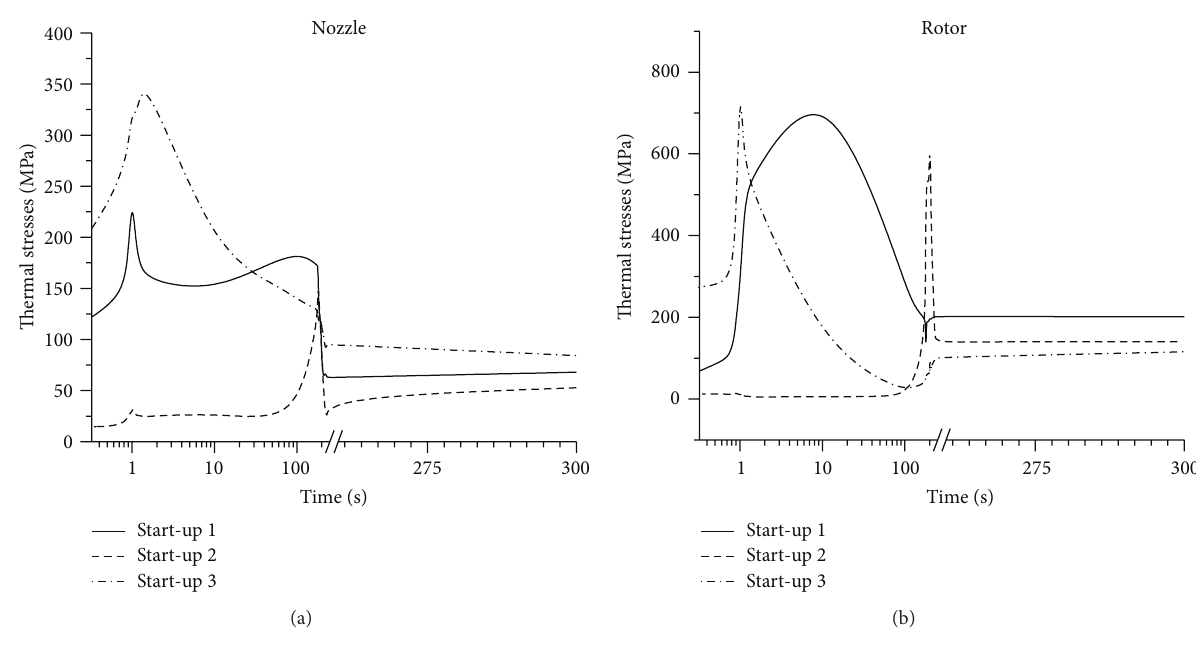
Figure 11: Stress evolution in the critical